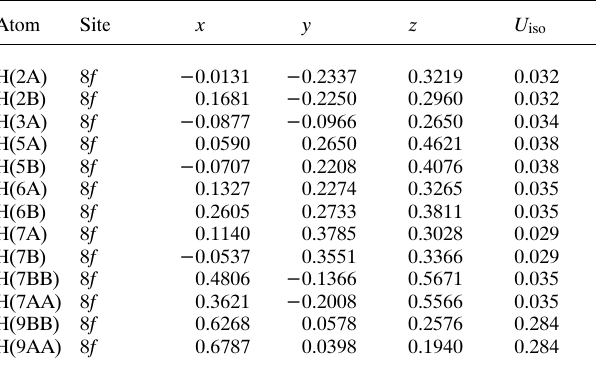
Table 2. Atomic coordinates and displacement parameters (in Å 2 ) . Atom